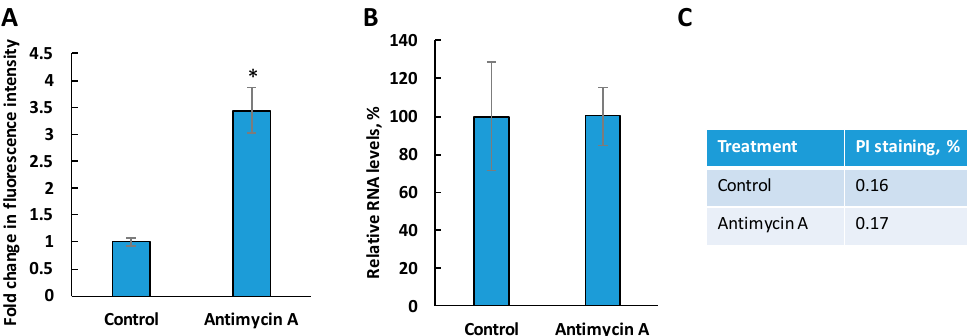
Figure 5. Antioxidant treatment of c14dm ̅ mutant does not restore RNA levels. ( A ) C14dm ̅ cells were inoculated at 4 × 10 5 cells/mL and treated with 1–4 mM of L-glutathione, and culture densities were determined after 48 h. ( B) Total RNA was extracted from 1 × 10 7 c14dm ̅ cells after L-glutathi- one treatment and quantified by NanoDrop. Percentages represent RNA levels relative to the un- treated control. ns: not significant.